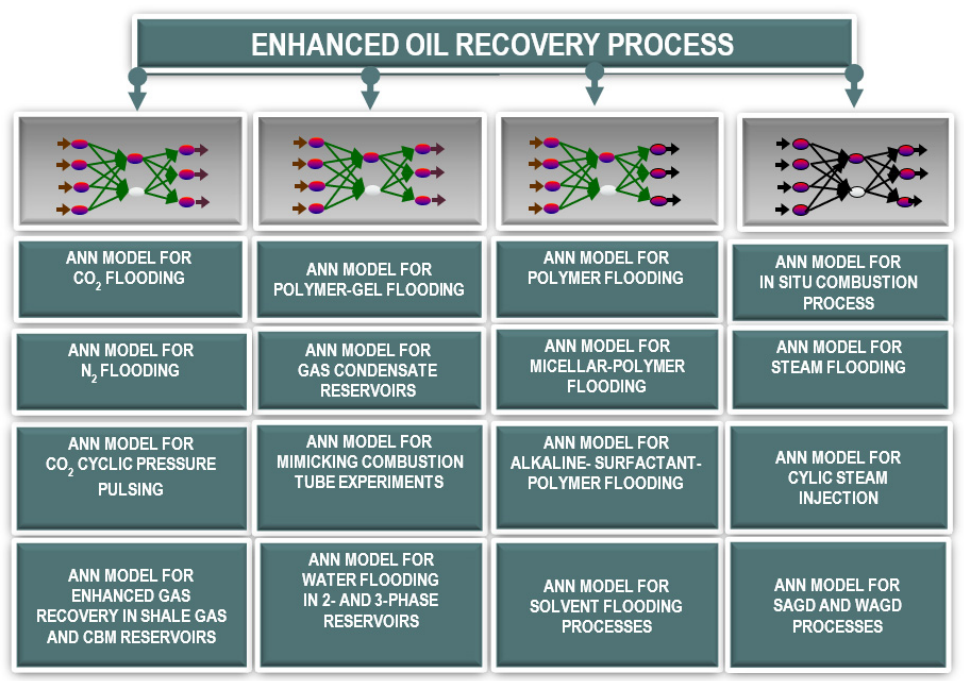
Figure 4. Enhanced oil/gas recovery related project process screening and design toolbox.